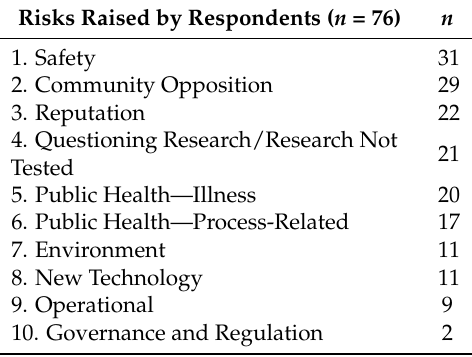
Table 2. Expert risk perceptions associated with the radiation-based treatment system for water, and frequency of occurrence.